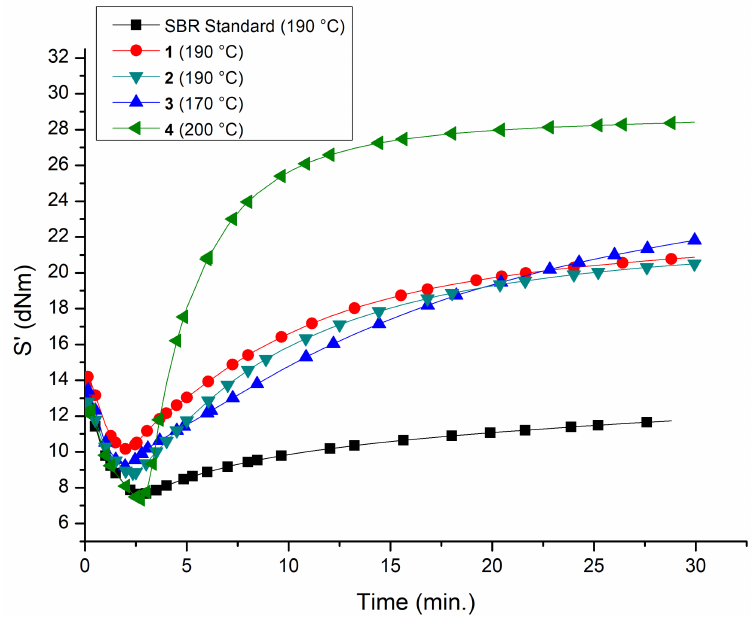
Figure 3. Torque crosslinking curves of first stage compounds.